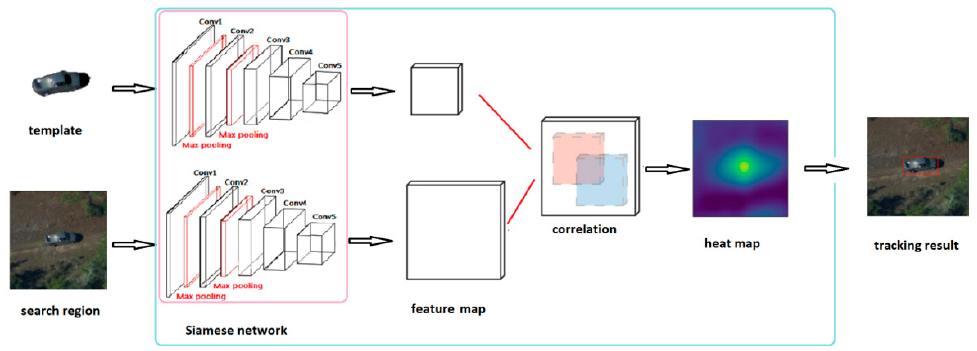
Figure 9. Architecture of our Siamese tracking network.